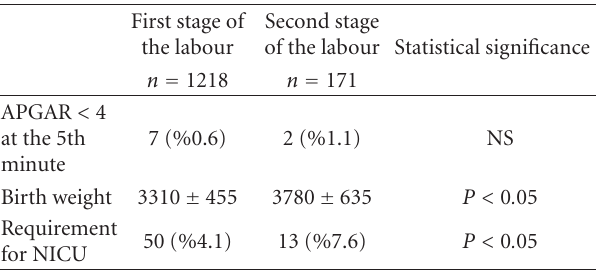
Table 3: Neonatal